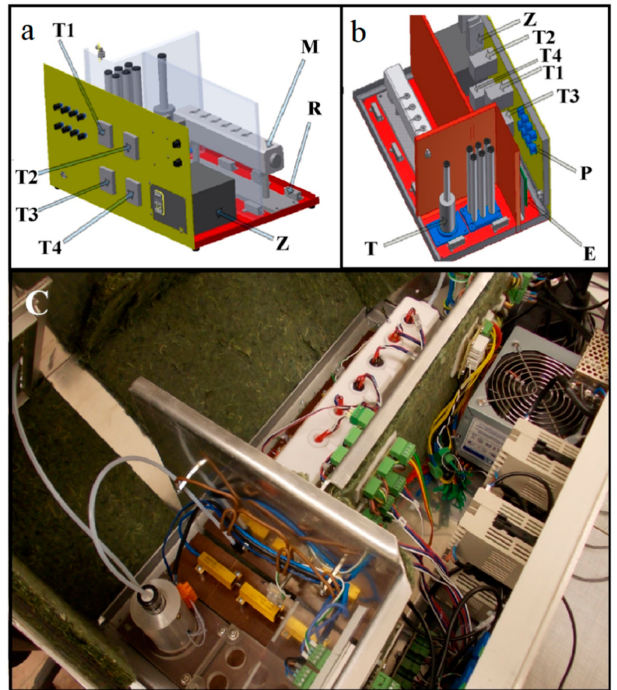
done on the data. [147]. Int. J. Environ. Res. Public Health 2020 , 17 , x